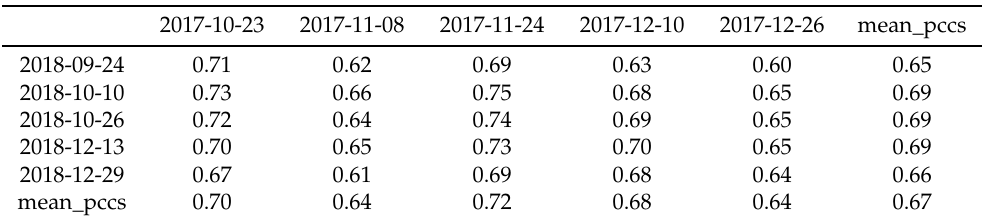
Table 2. The Pearson correlation coefficient between images acquired from October 2017 to